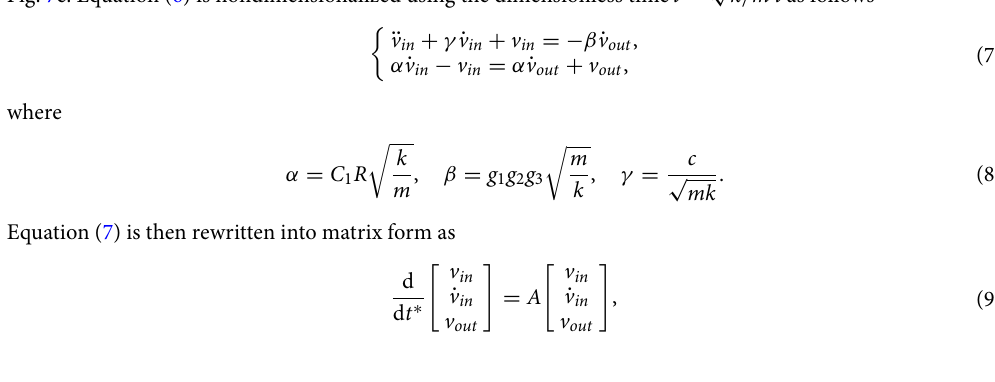
Fig. 7c. Equation (6) is nondimensionalized using the dimensionless time t ∗ = √ k / m t as follows